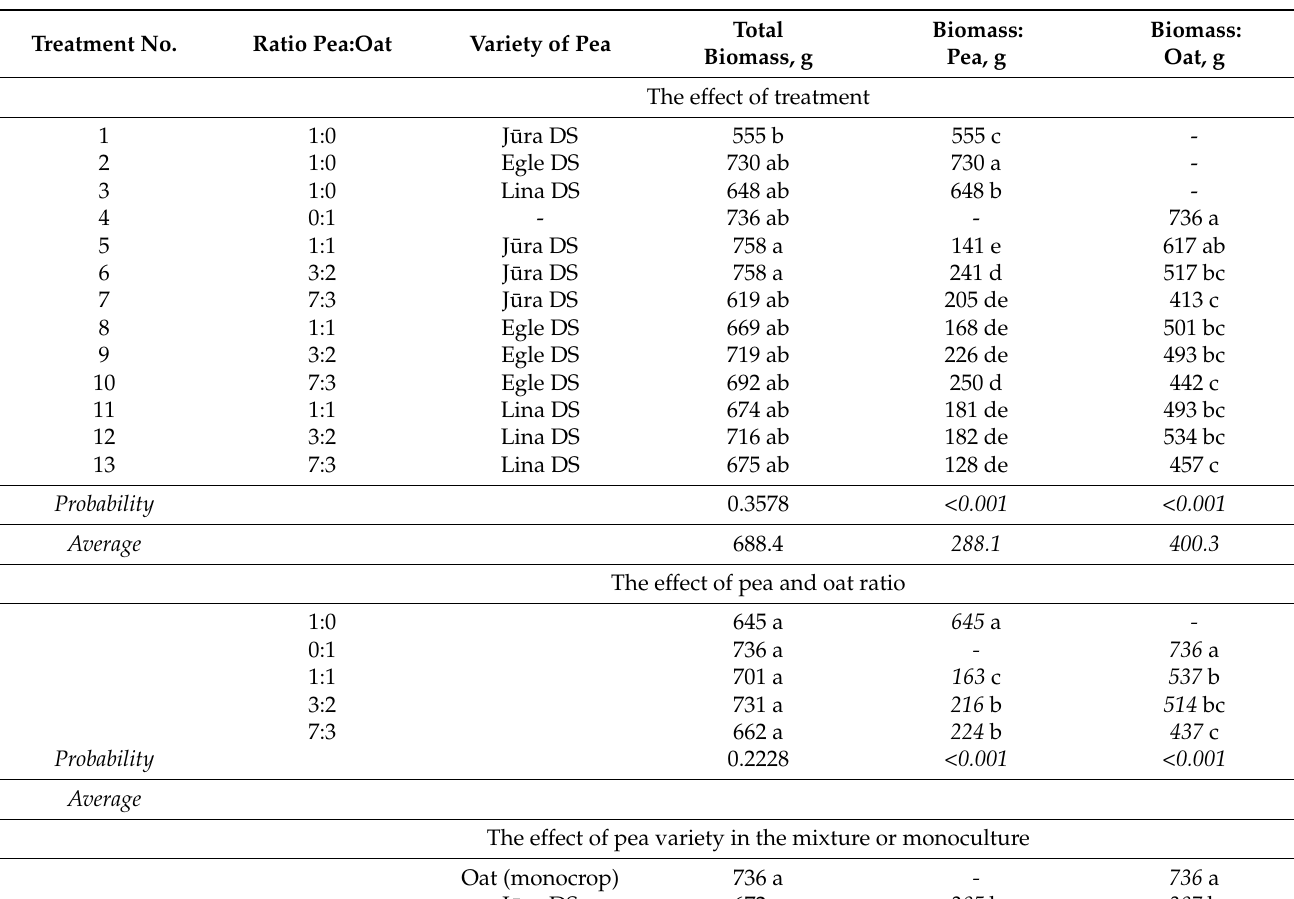
Table 3. The biomass and straw weight of crops per unit of area (g m − 2 ), averaged across the three years, depending on the pea sowing rate and the different